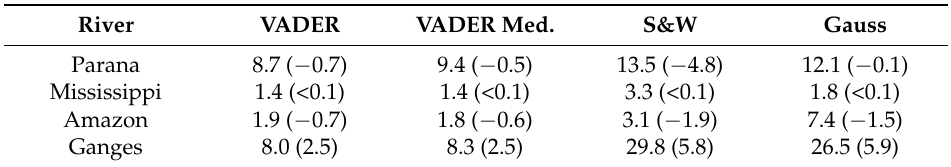
Table 3. RMS and mean value (in brackets) of phase shift in days derived from the 143 month closed-loop time series for four river